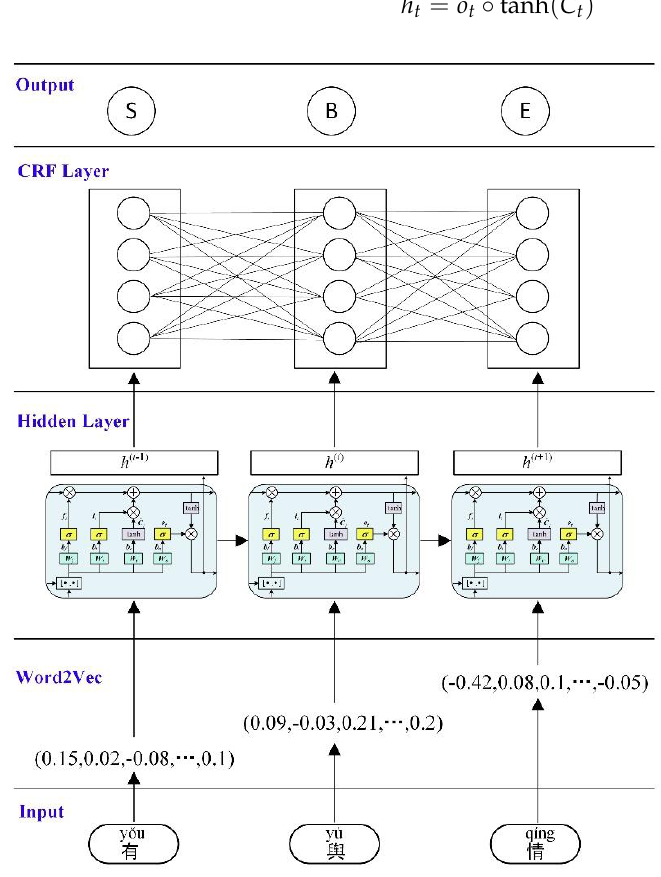
Figure 3. Chinese word segmentation architecture.